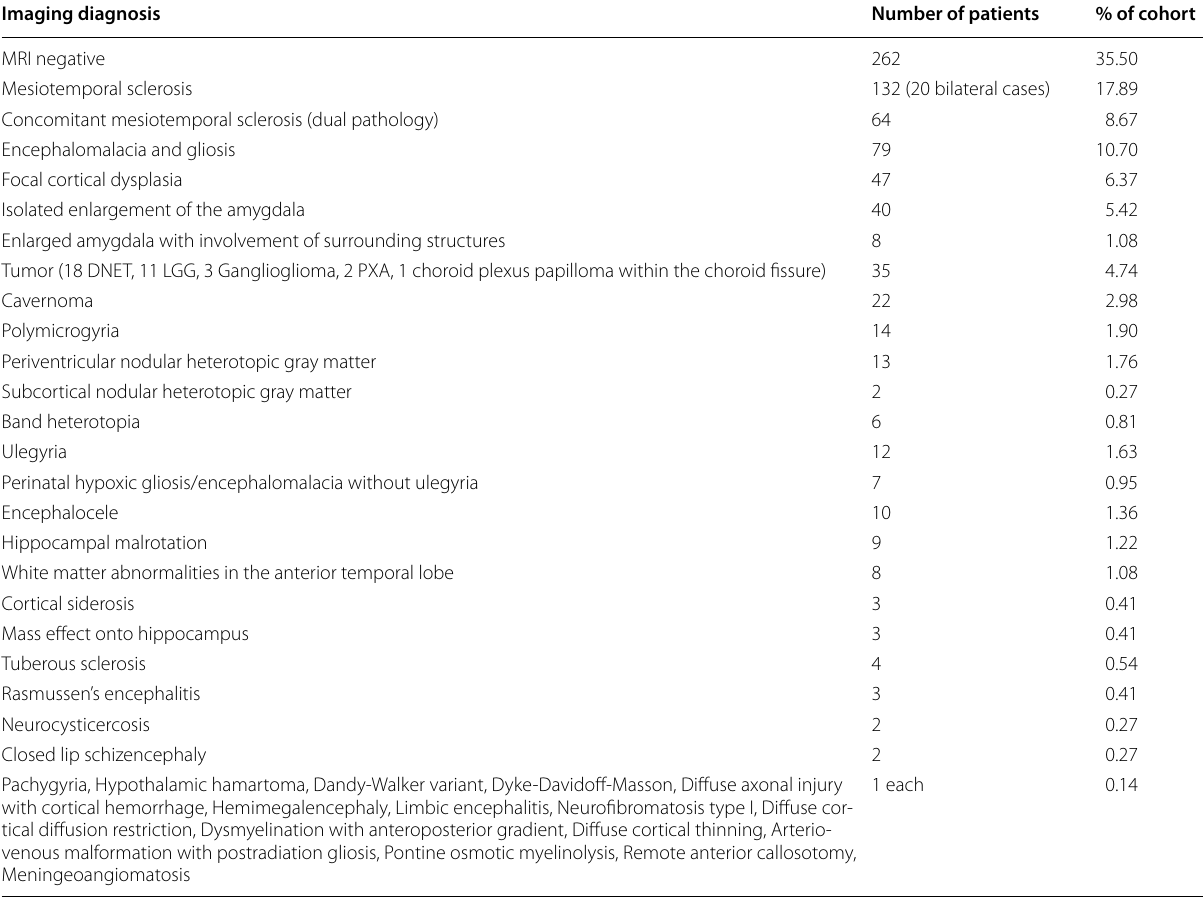
Table 1 Complete list of all imaging diagnoses encountered in the cohort Imaging diagnosis